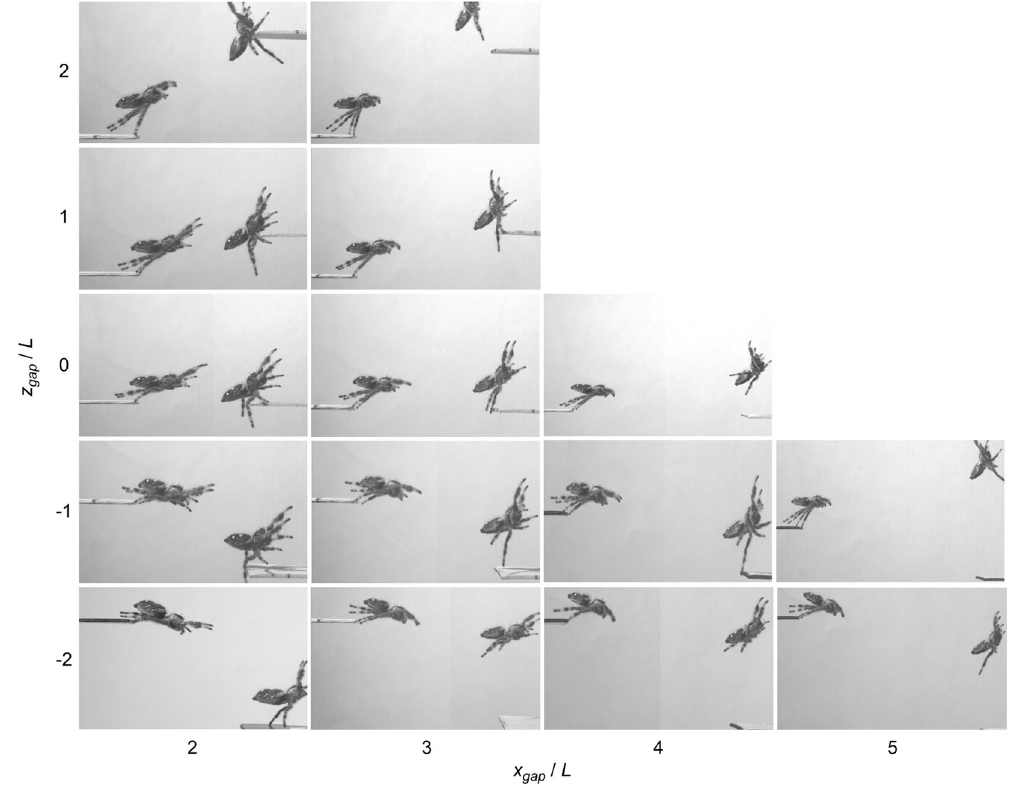
Figure 4. Visual comparison of body attitude and leg arrangement at the start and end of the jumping tasks. The starting frame is the instant of take-off. The end frame is taken either at the point where the spider makes contact with the landing platform, or where the centre of gravity passes the longitudinal location of the task landing point, depending on which happens